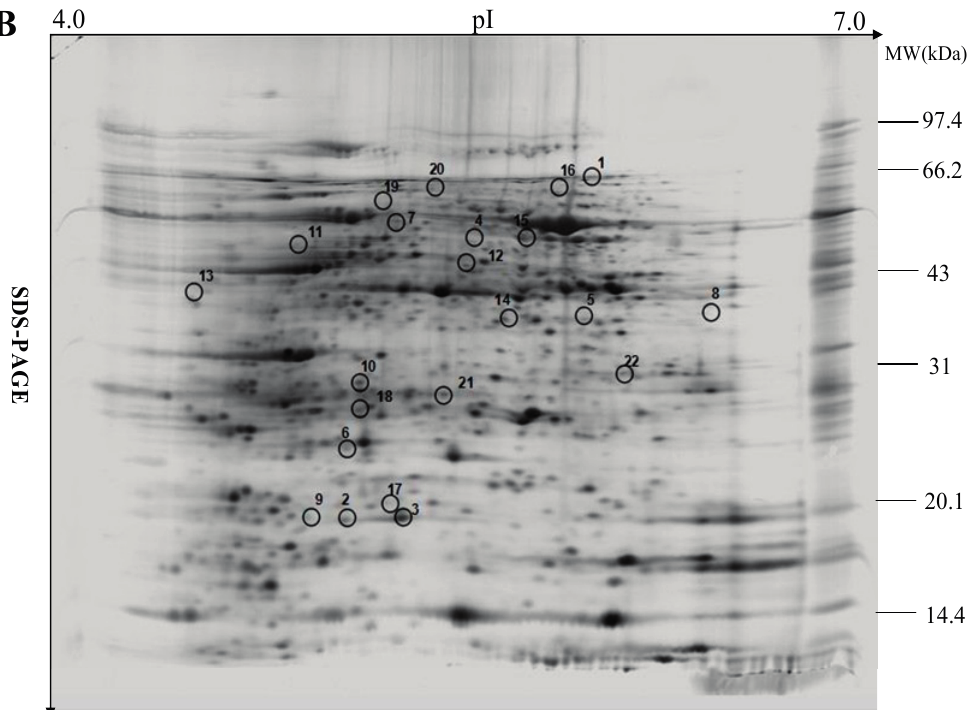
Figure 4. 2-DE analysis of proteins extracted from control leaf sample ( A ) and PEG-stressed leaf sample ( B ) of maize